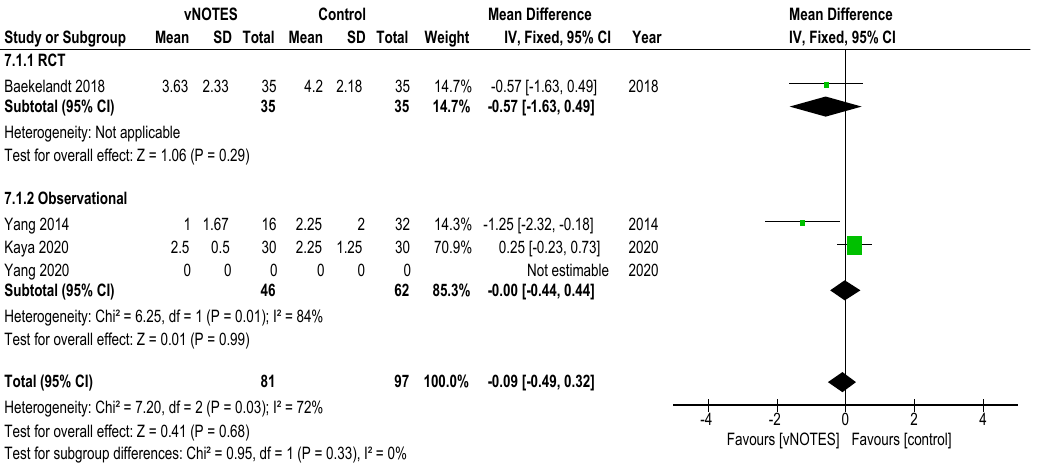
Figure 6. Forest plot of comparison vNOTES versus control, outcome: VAS pain scores Day 1.